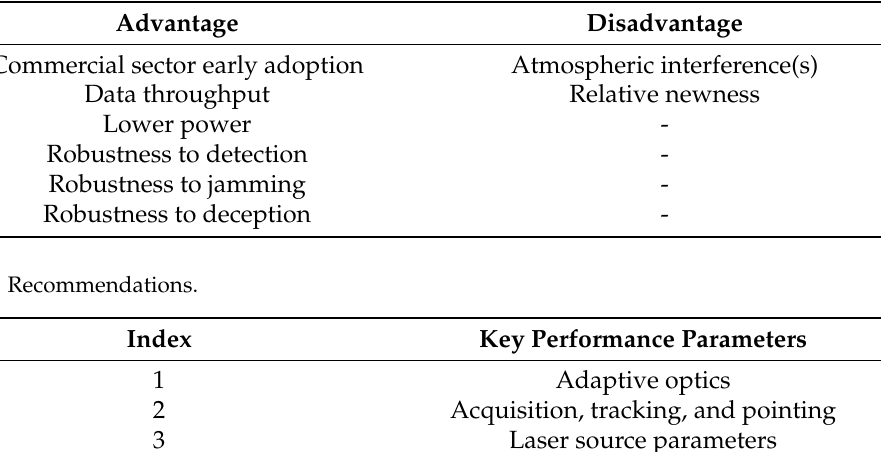
Table 3. Advantages and disadvantages of laser uplinks and downlinks.